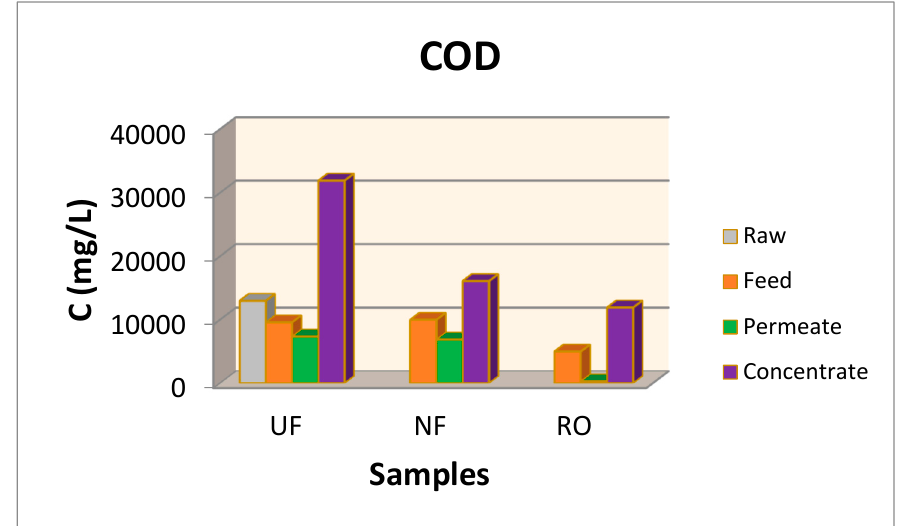
Figure 11. Chemical oxygen demand at the raw, feed, permeate and concentrate streams at the UF, NF, RO membranes.